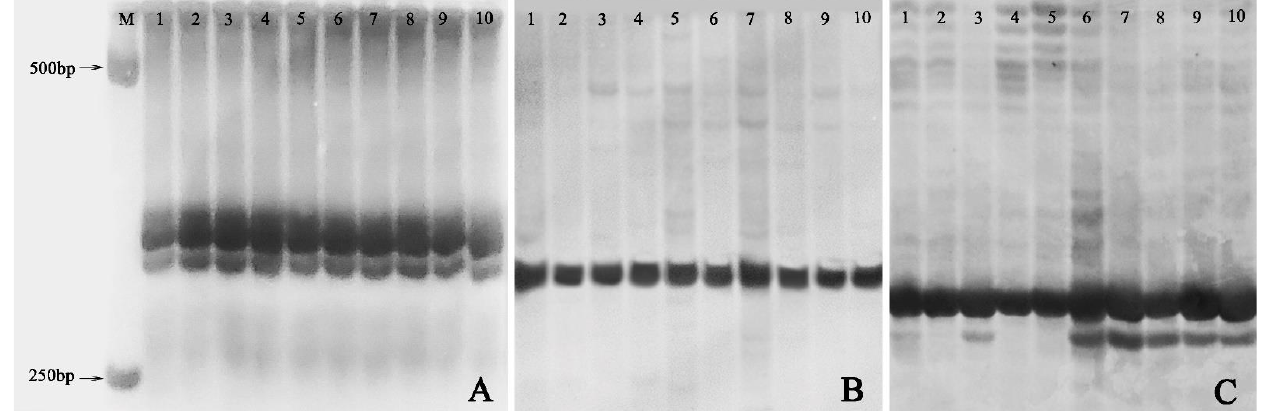
Figure 6. SSR profiles of the normal-type plants, the VT1, and the VT2. ( A ) Banding patterns of SSR marker Ginger 58; ( B ) Banding patterns of SSR marker Ginger 92; ( C ) Banding patterns of SSR marker Ginger77. M: 1000 bp DNA marker; 1 – 2: randomly selected two plants of normal-type plants; 3 – 5: the VT1; 6 – 10: the VT2.